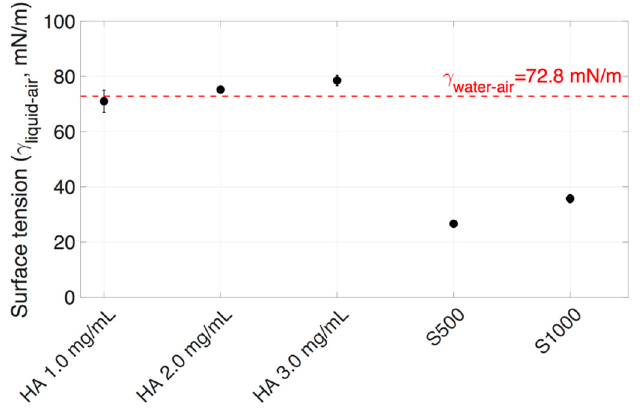
Figure 5. Interfacial surface tension of HA, SO (S500 and S1000), and (red dotted line) water with air at 25 °C.